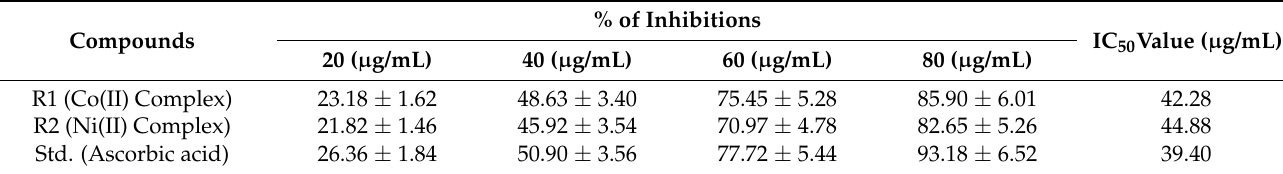
Figure 10. In vitro antioxidant (DPPH) activity of Co(II) and Ni(II) complexes. Table 4. In vitro antioxidant (DPPH) activity of metal